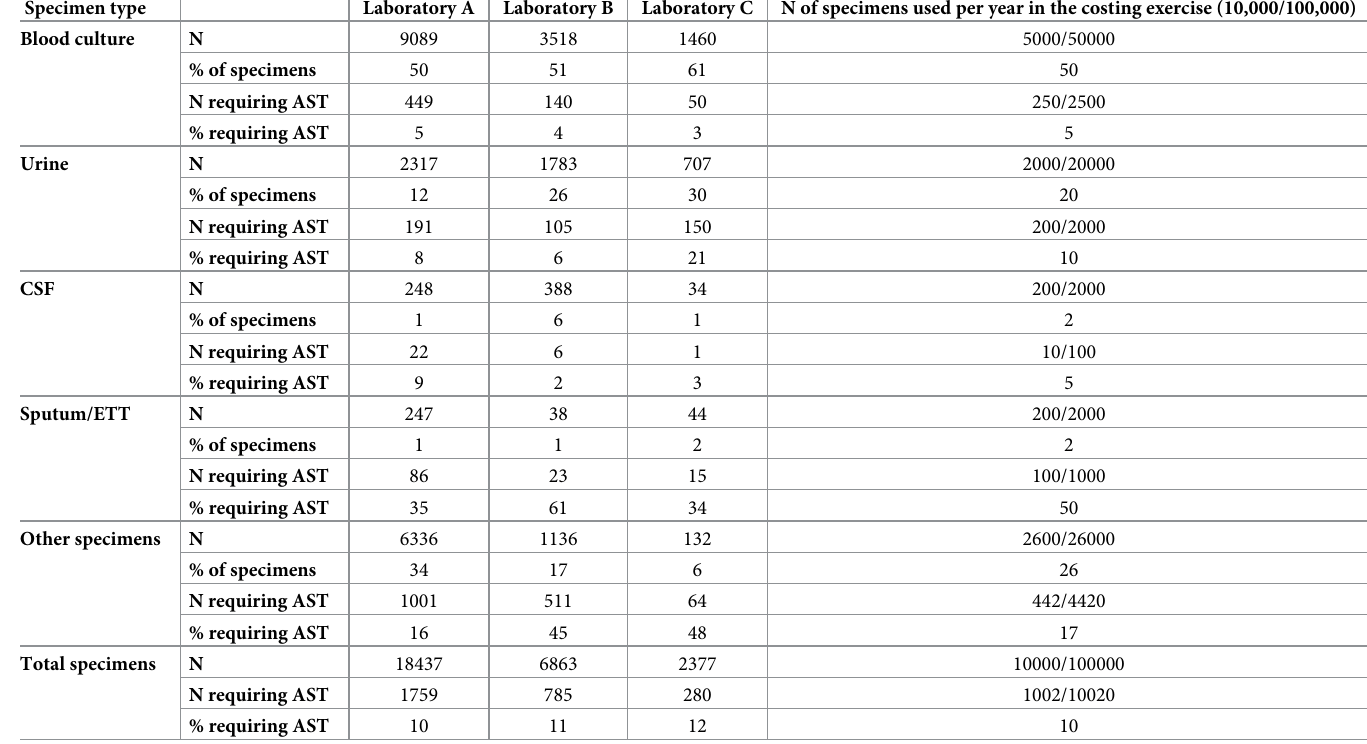
Table 1. Number of specimens processed and requiring antimicrobial susceptibility testing for Laboratory A, B and C in 2019, and the estimated number of samples used in this study for costing calculations. N = number, AST = antimicrobial susceptibility testing, ETT = endotracheal aspirates. Specimen